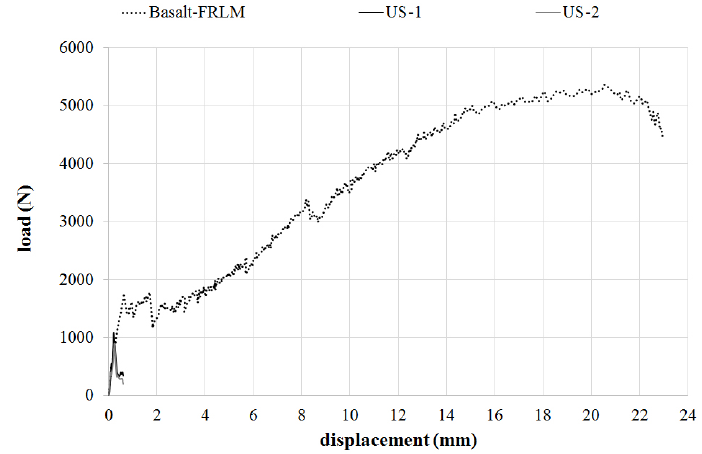
Figure 6. Load ‐ displacement curves of un ‐ strengthened and Basalt ‐ FRLM ‐ strengthened arch.